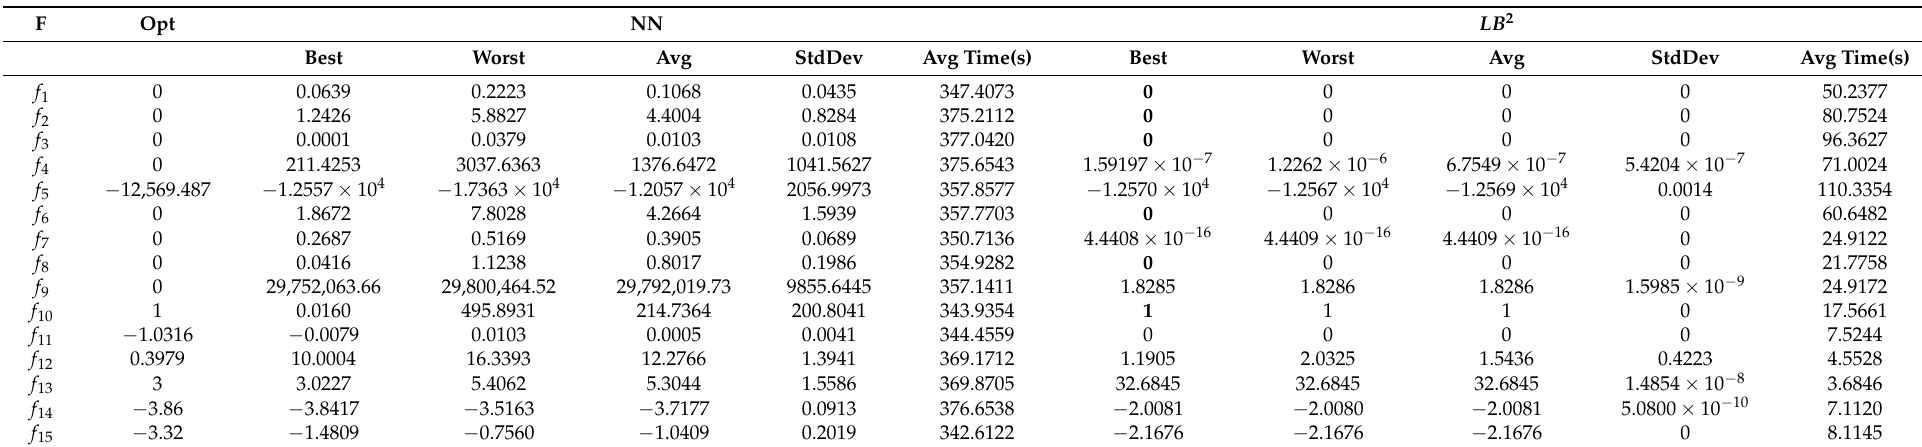
Table 11. Results comparison of NN vs. LB 2